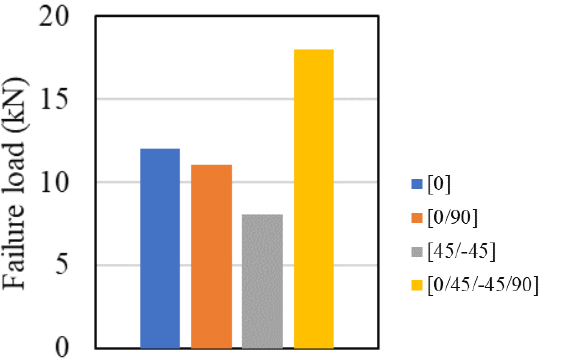
Figure 18. Effect of stacking sequence on failure load composite single lap joint. Adapted from [43].